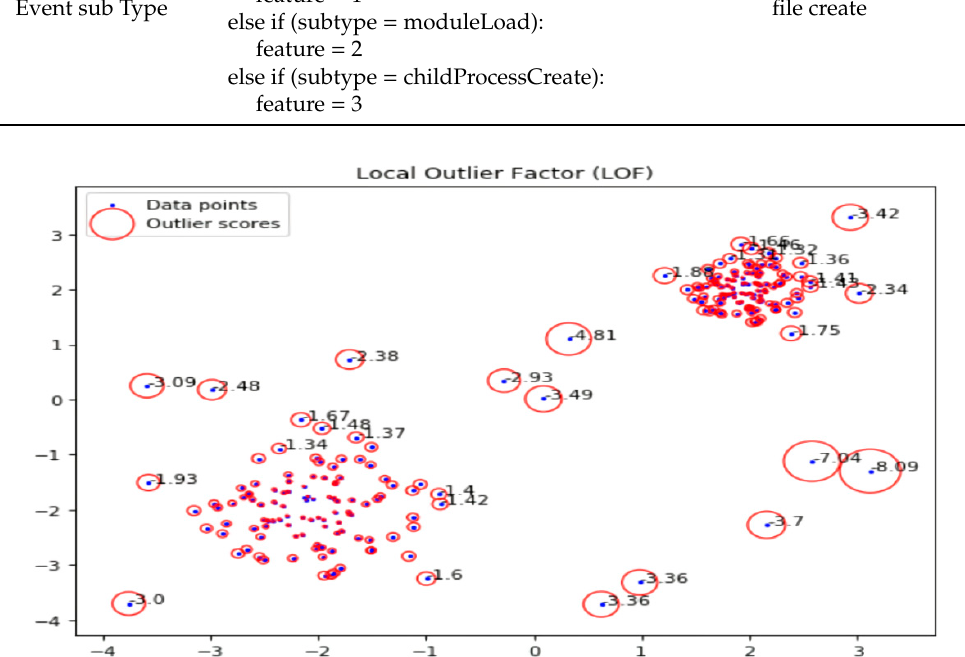
Figure 6. Examples of local outlier factor (LOF) values in different density populations.